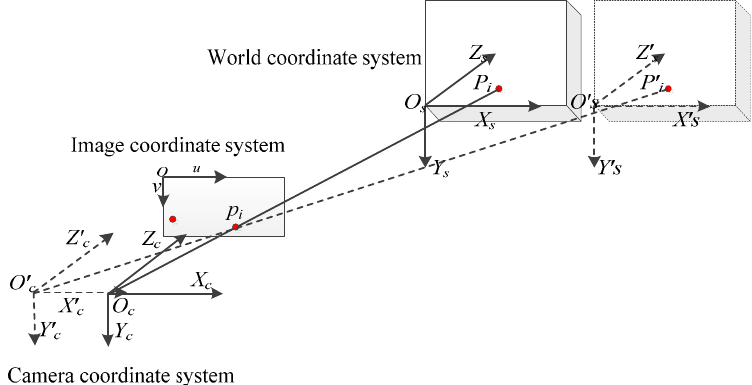
Figure 2. Relationship between the principal point and translation.